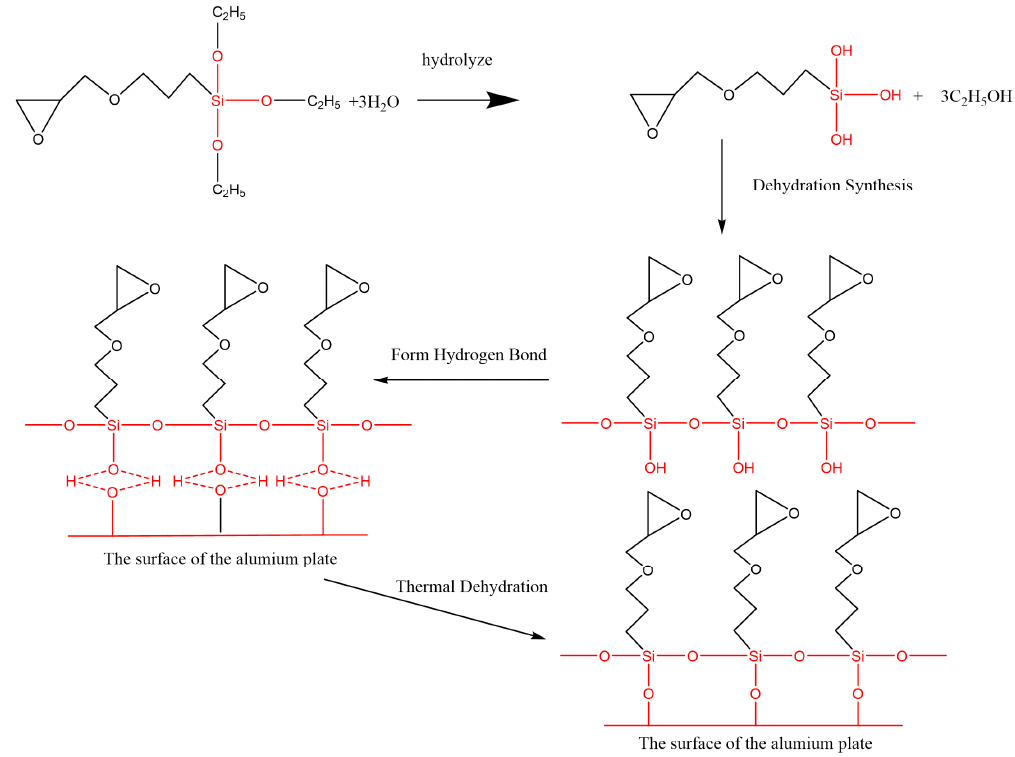
Figure 12. Condensation reaction of the silane coupling agent on the surface of the Al alloy sheet.